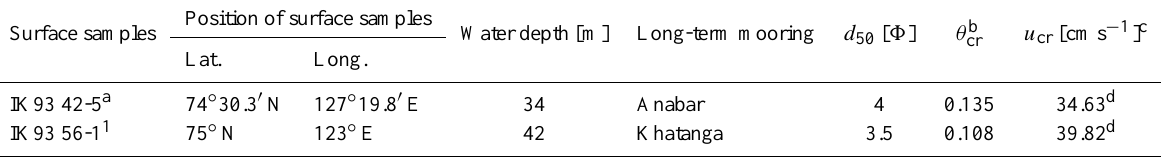
Table 1. Positions, median grain size ( d 50 ) for the surface samples after Lindemann (1994), threshold shields parameter ( θ cr ), and threshold current velocity for incipient grain motion ( u cr ) in the vicinity of the respective long-term mooring